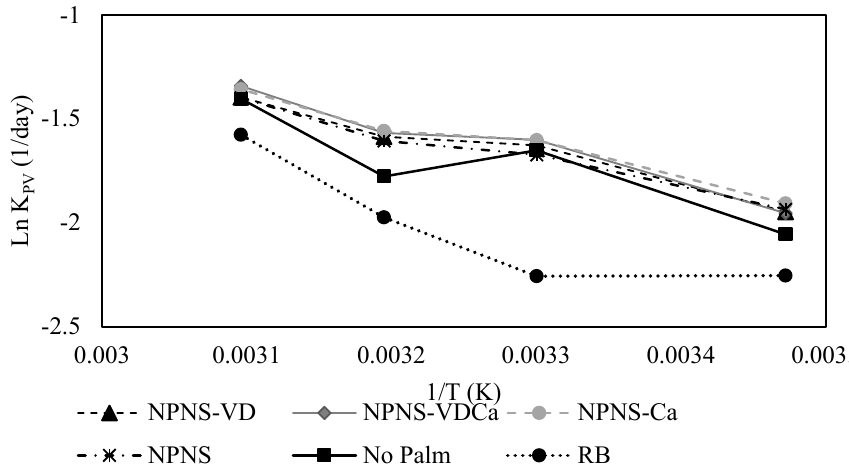
Figure 5. Arrhenius graph from plotting the natural logarithm of the rate constant Ln k PV for chocolate spread stored at 288.15, 303.15, 313.15, and 323.15 K against reverse absolute temperature (1/K). RB, reference brand; NPNS, spreadable chocolate without palm oil and sugar; NPNS-VD, spreadable chocolate without palm oil and sugar fortified with vitamin D; NPNS-VDCa, spreadable chocolate without palm oil and sugar fortified with vitamin D and Mg-CaCO 3 nanoparticles; NPNS-Ca, spreadable chocolate without palm oil and sugar fortified with Mg-CaCO 3 nanoparticles. Table 4. Arrhenius equations, activation energy (E a KJ/mol K), rate constant at 293.15 and 298.15 K (k 293.15 and k 298.15 ), Q10, correlation coefficient value (r 2 ), and shelf-life at 293.15 and 298.15 K estimated for different chocolate spread